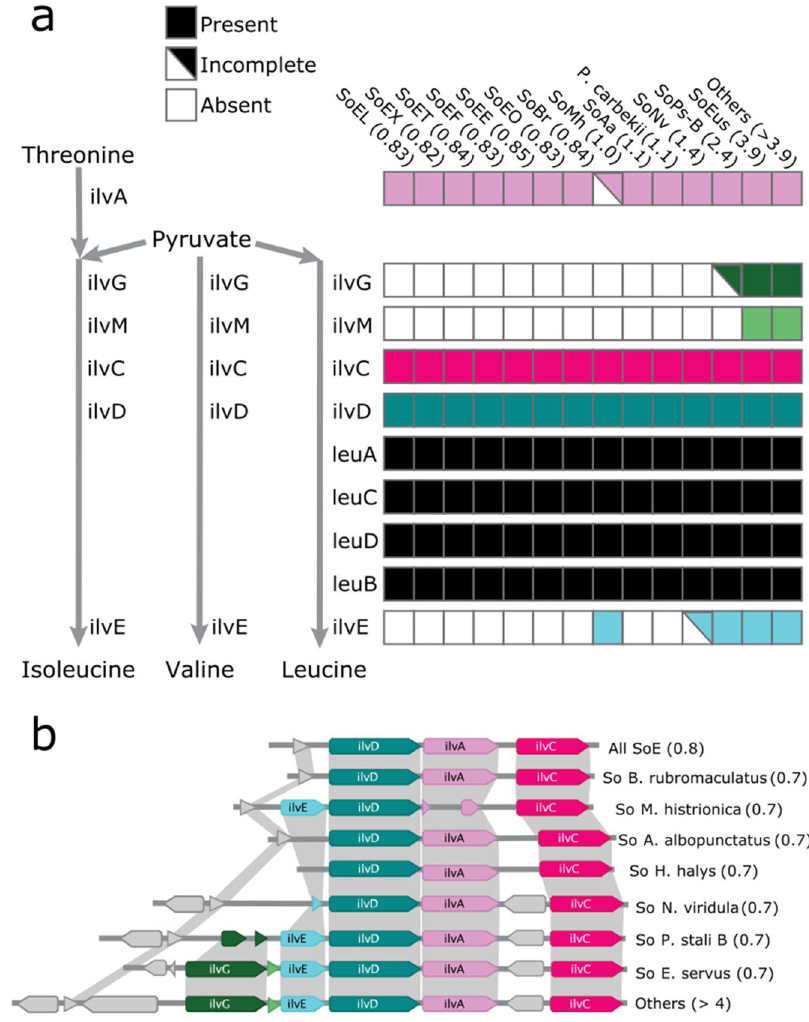
Figure 3. Presence of genes involved in branched chain amino acid biosynthesis pathway. The presence of genes in each genome according to the order of the pathway ( a ) and gene order and presence in the ilv operon region ( b ). Numbers in parentheses represent genome sizes in Mb. Colors are used to match genes in between panels for ease of visualization. Unlabeled grey pentagons denote genes not directly involved in the